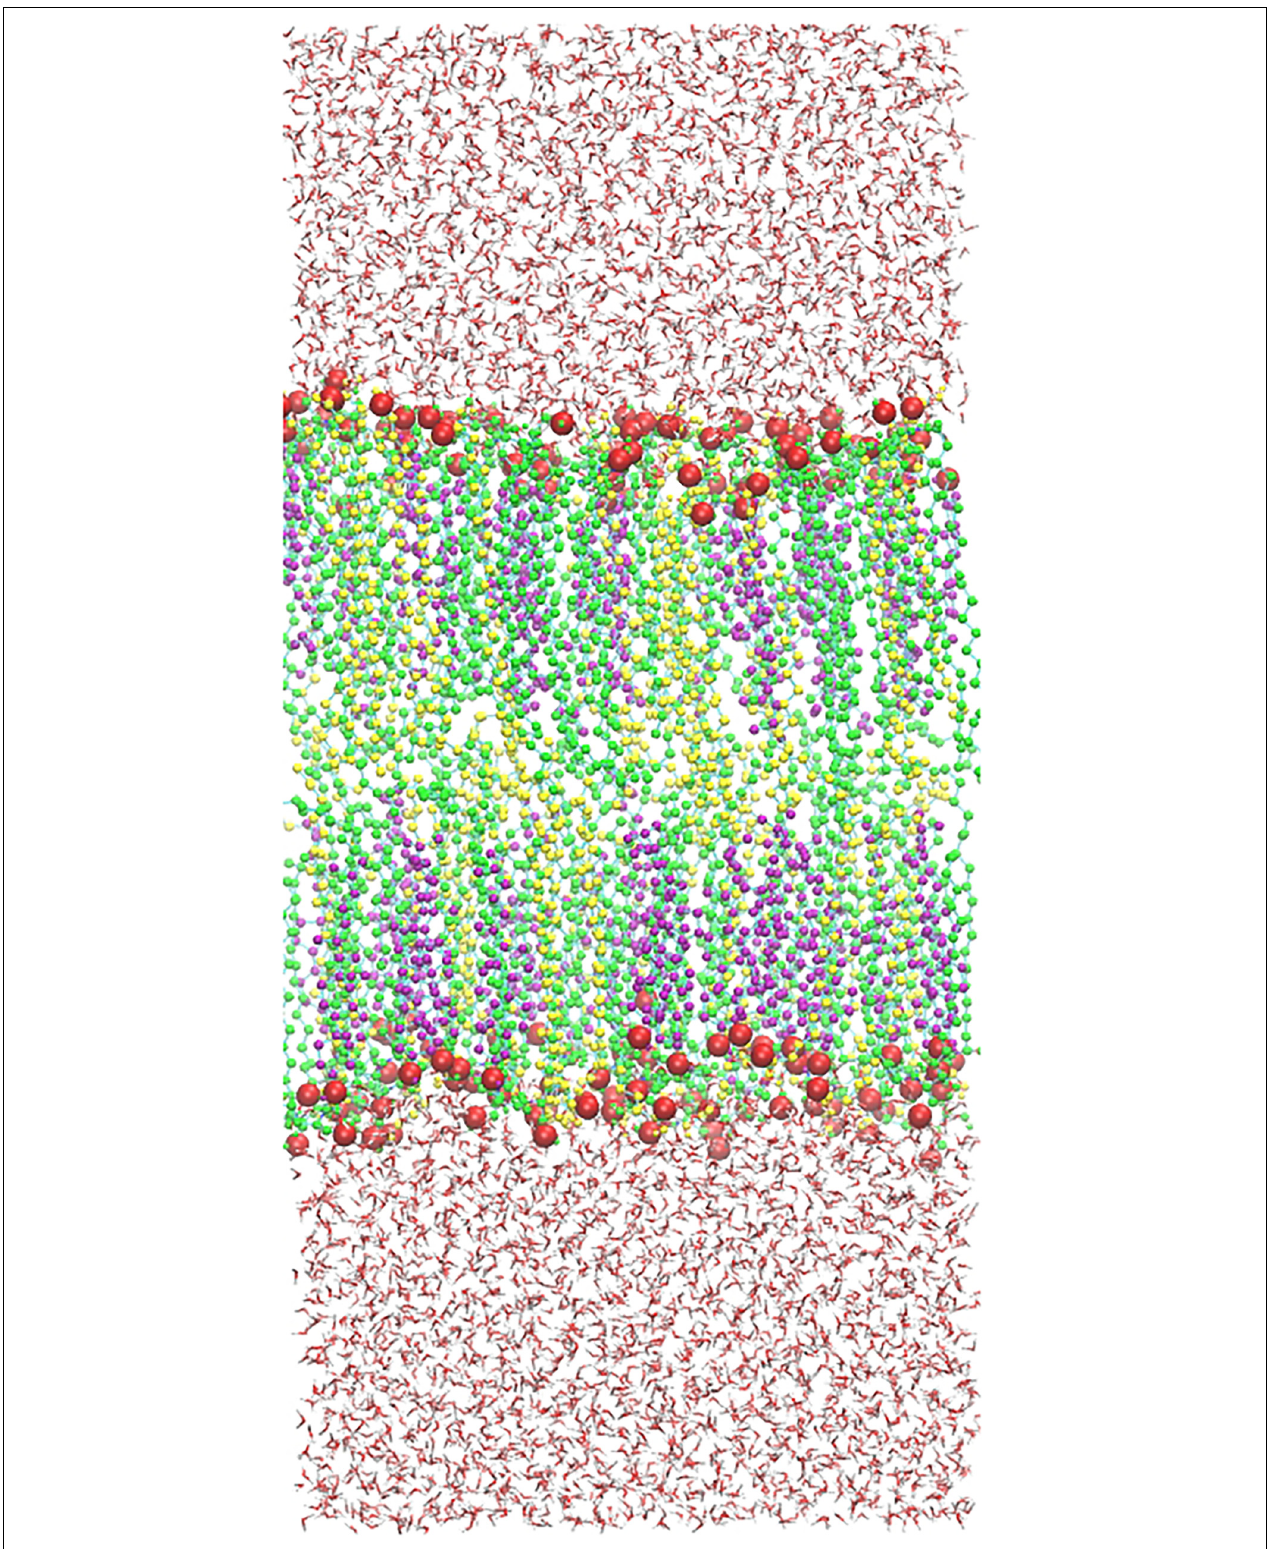
FIGURE 2 | Native structure of a skin lipid bilayer containing 52 CER (Green), 50 CHO (Purple), 52 FFA (Yellow) molecules, and 5210 water molecules. Polar heads (Oxygen) are shown in red sphere [van der Waals (VDW)].